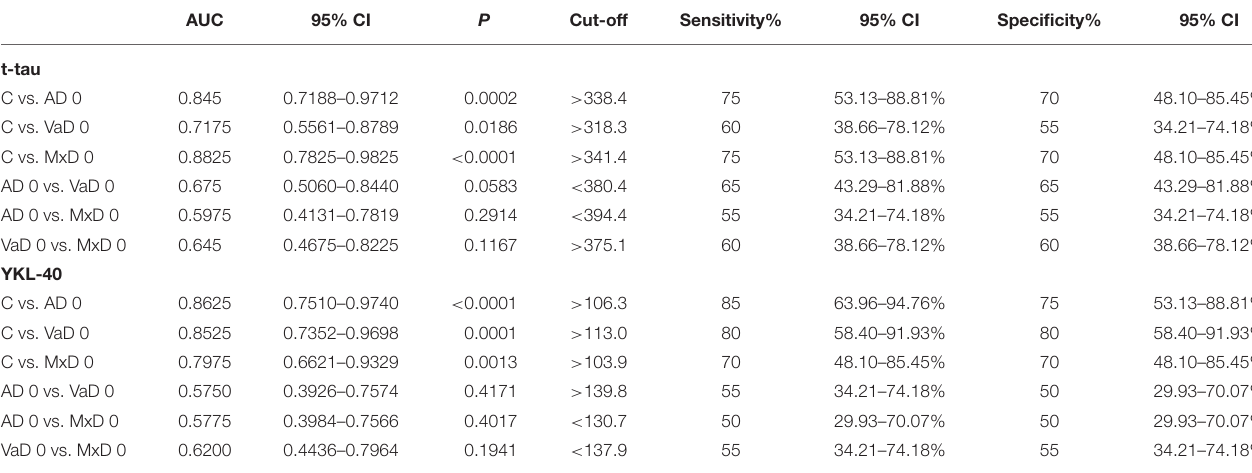
TABLE 3 | ROC analysis of serum YKL-40 in different types of dementia.